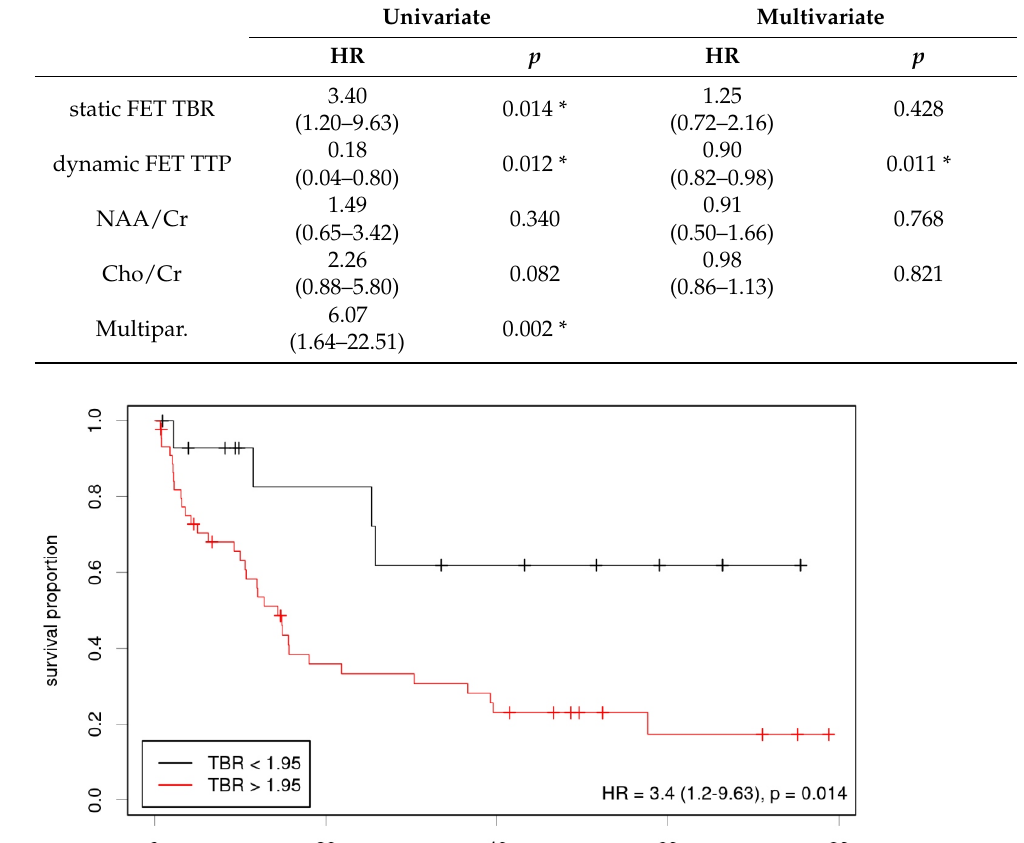
Figure 6. Kaplan – Meier plot showing low- and high-risk groups according to multiparametric com- bination.